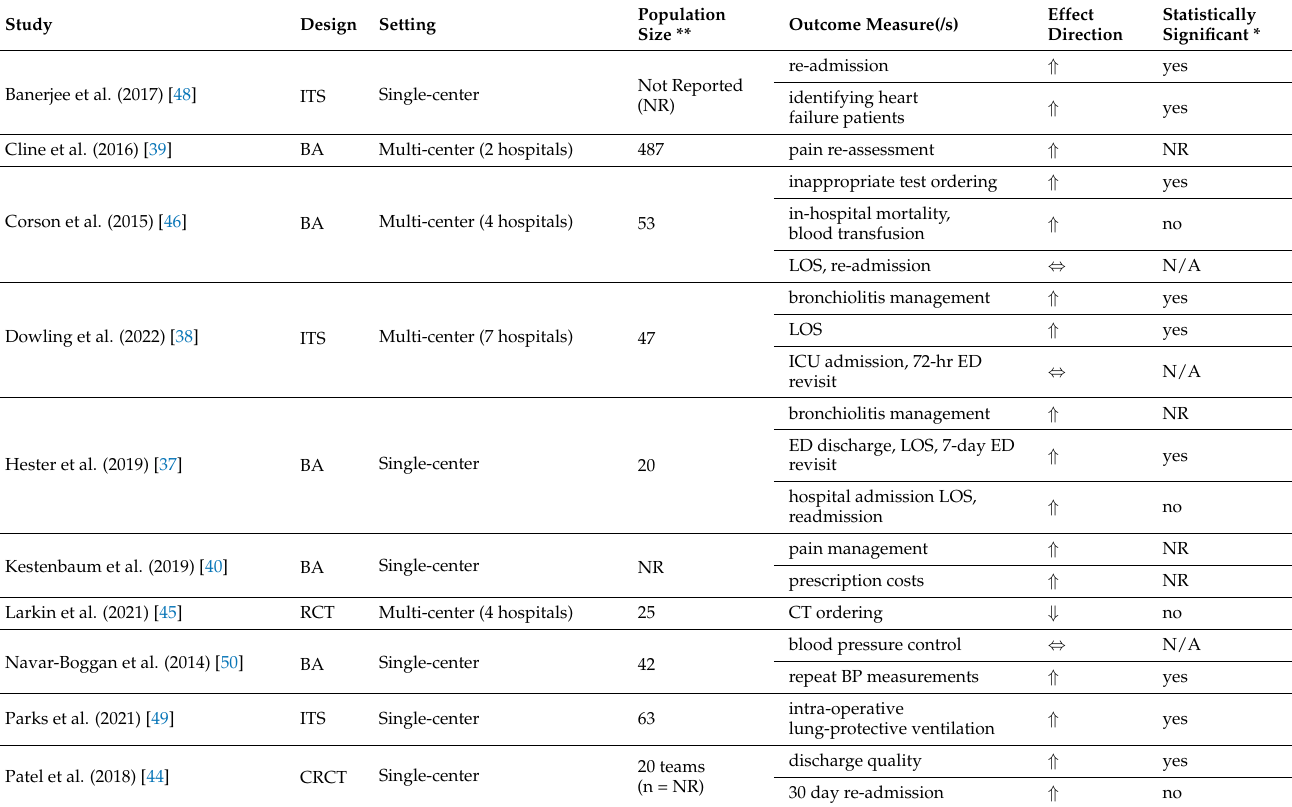
Table 1. Study Characteristics and